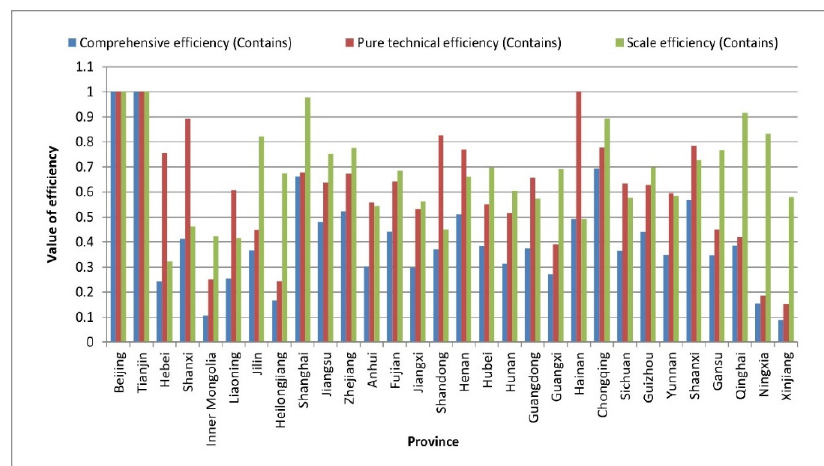
Figure 3. Efficiency values of production based intensity index.